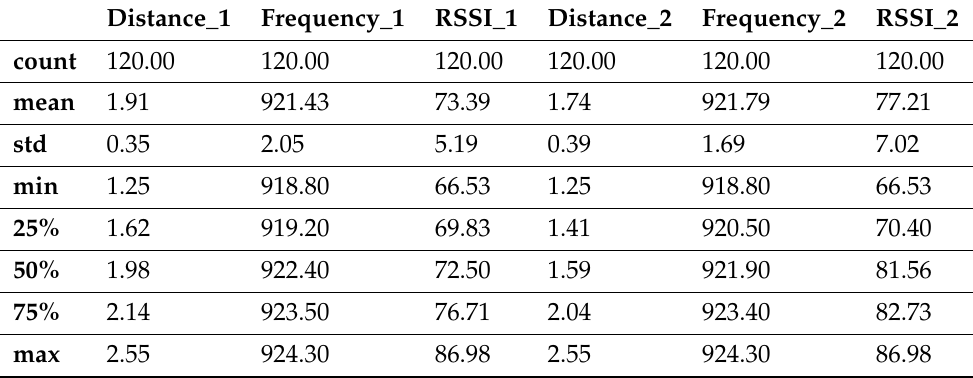
Table 3. Numerical variables and their statistical